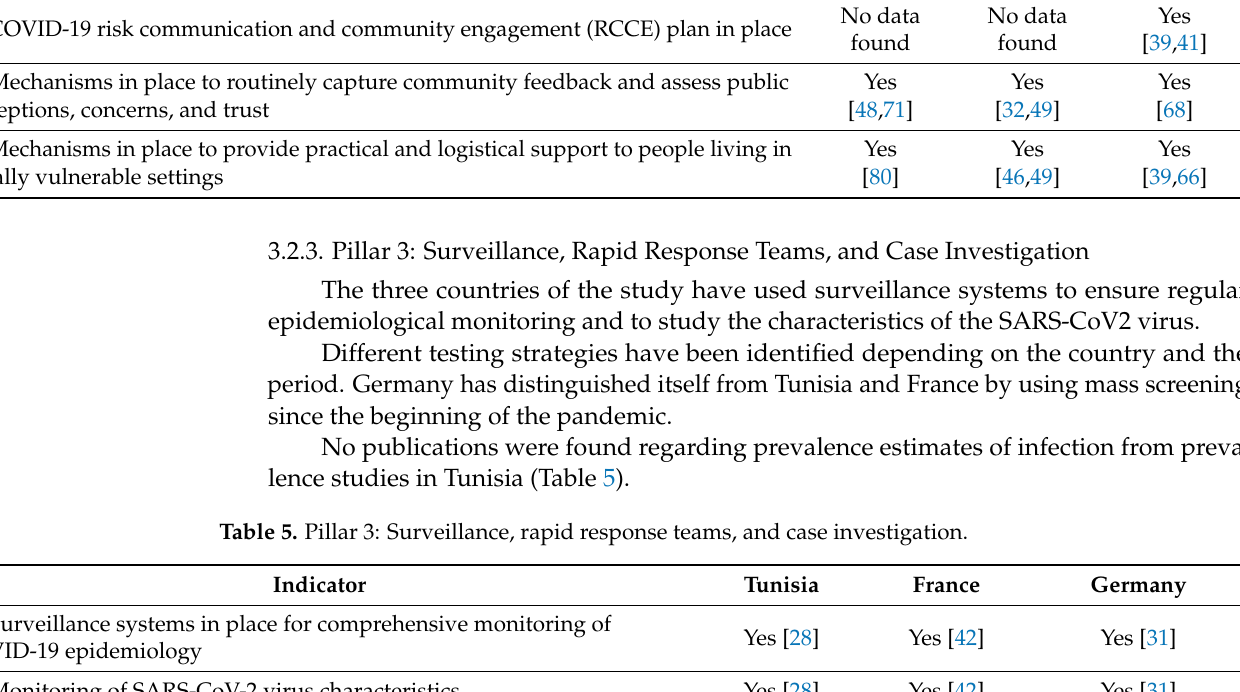
Table 4. Pillar 2: Risk communication and community engagement. Indicator